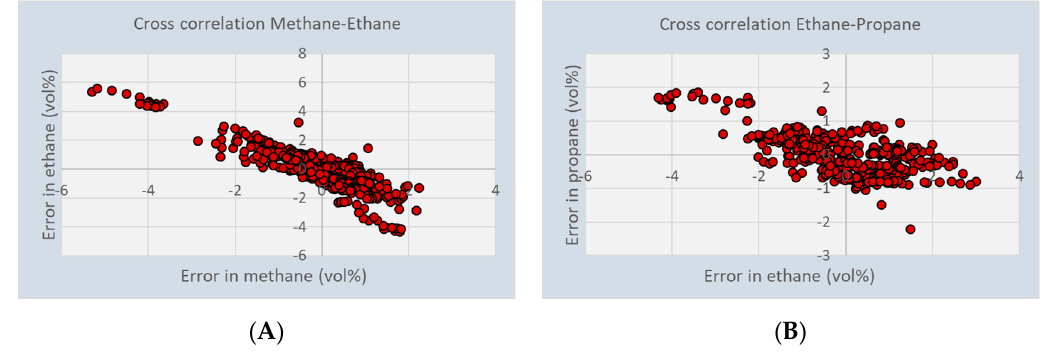
Figure 7. Cross sensitivity of the capacitive array sensor between ( A ) methane and ethane and ( B ) between ethane and propane.